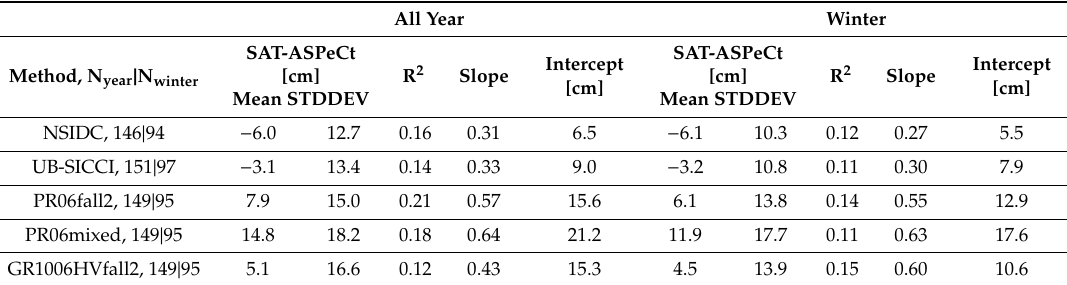
Table 6. Summary of the results shown in Figure 10 (left- and right-most columns) with the results obtained for UB-SICCI (see first paragraph of Section 4.1) added. N year and N winter denote the number of data pairs for “All year” and “Winter”. All Year